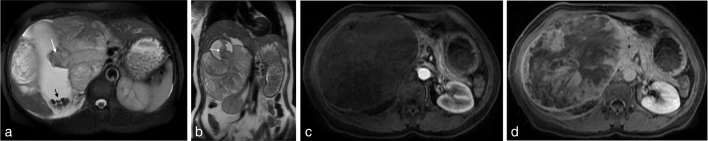
Transverse fat-suppressed single-shot fast spin-echo T2 weighted image (a) and coronal non-fat-suppressed single-shot fast spin-echo T2 weighted image (b) show a distended gallbladder with intraluminal polypoid lesions (arrows, a, b) in continuity with an exophytic expansile lesion occupying the right upper quadrant. This mass appears heterogeneous and with moderately high T2 signal intensity. Transverse gadolinium-enhanced fat-suppressed T1 weighted three-dimensional gradient-echo MRI obtained through the abdomen at the arterial (c) and interstitial (d) phases show the hypovascular nature (c) with progressive enhancement over time (d). Note the presence of gallbladder calculi, easily recognized on T2 weighted image (arrowhead, a).